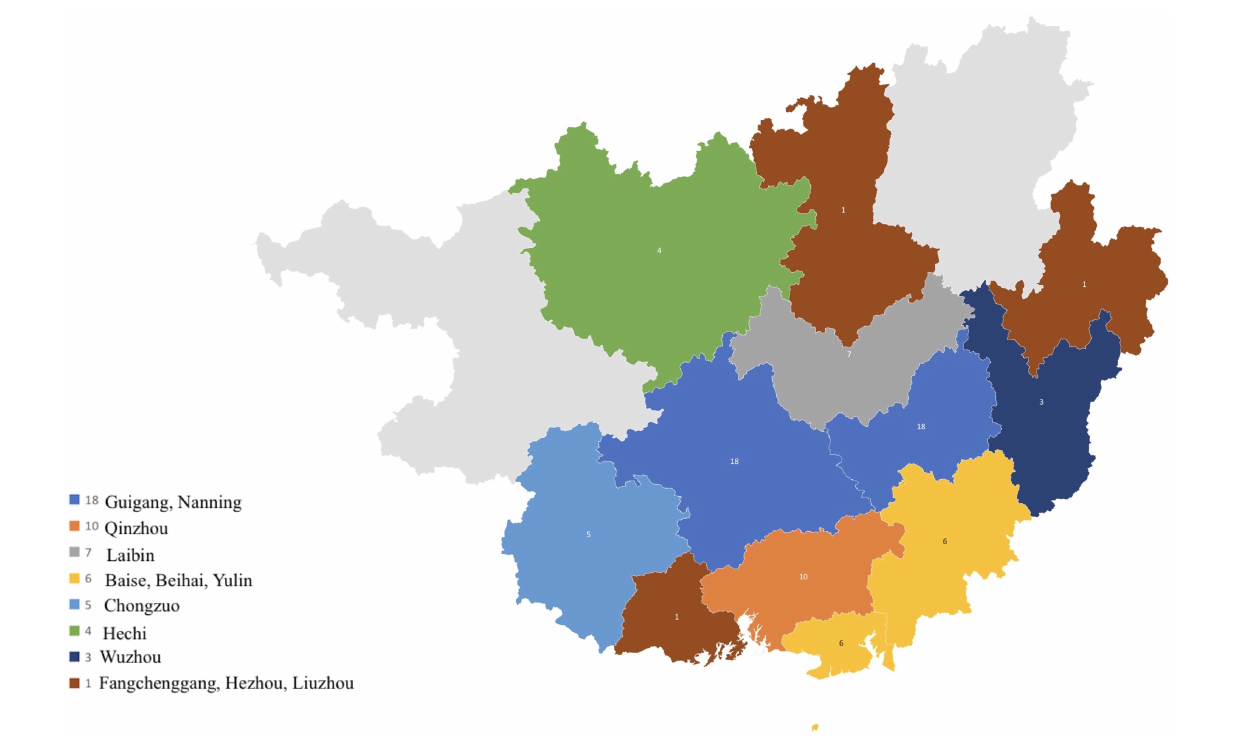
FIGURE 1 | Geographic distribution of cryptococcosis patients from Guangxi province, Southern China.